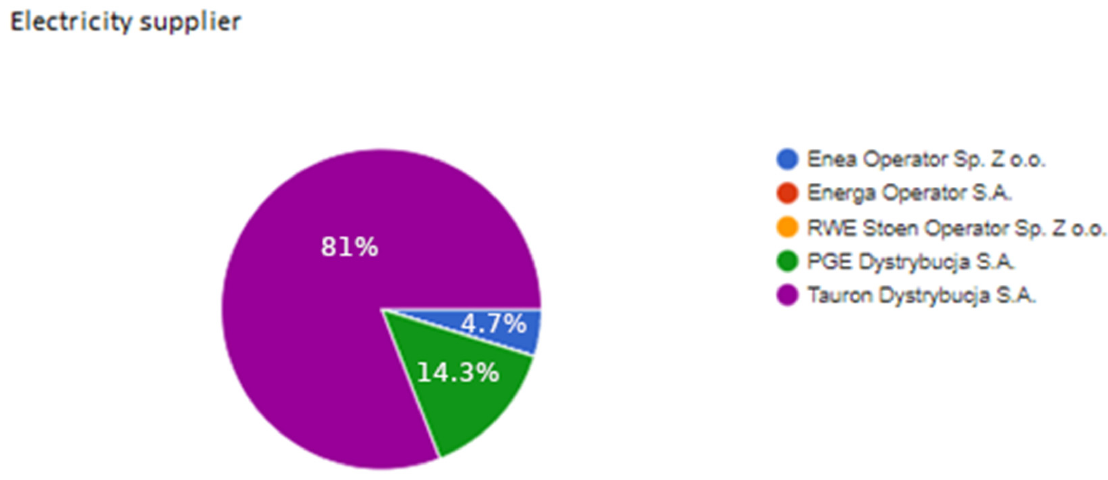
Figure 16. Energy distributors in Poland.